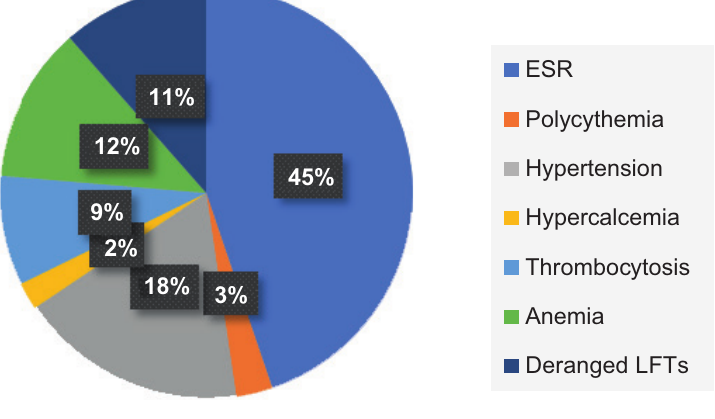
Figure 2: Paraneoplastic